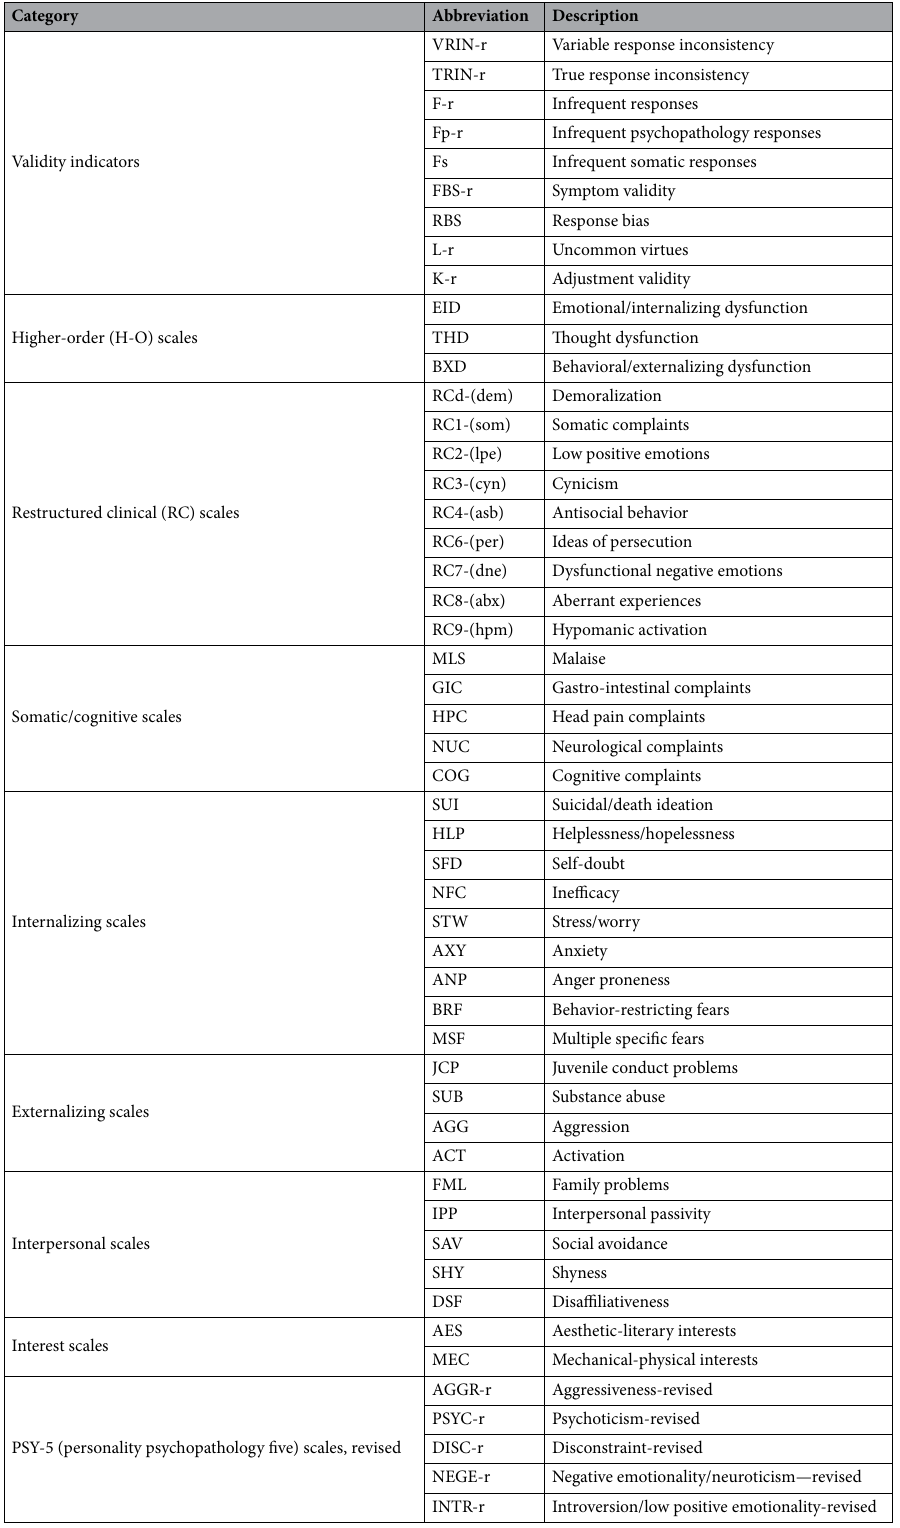
Table 4. The MMPI-2-RF variables used for machine